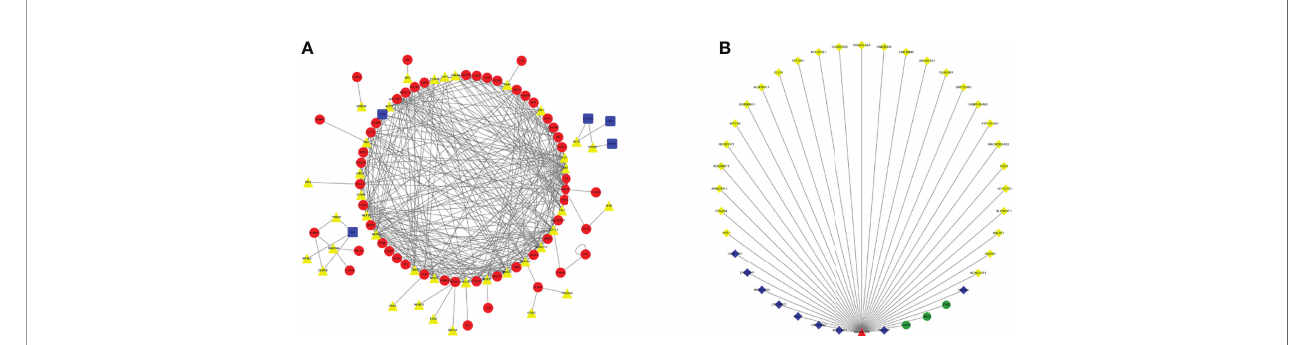
FIGURE 1 | TF Regulatory Network and ceRNA Network. (A) TF network. The red circles represent high-risk IRGs, the blue squares represent low-risk IRGs, and the yellow triangles represent TFs. (B) ceRNA network based on prognosis-related genes. The light-yellow diamonds represent upregulated DElncRNAs, the blue diamonds represent downregulated DElncRNAs, the green circles represent mRNAs, and the red triangles represent DEmiRNAs.